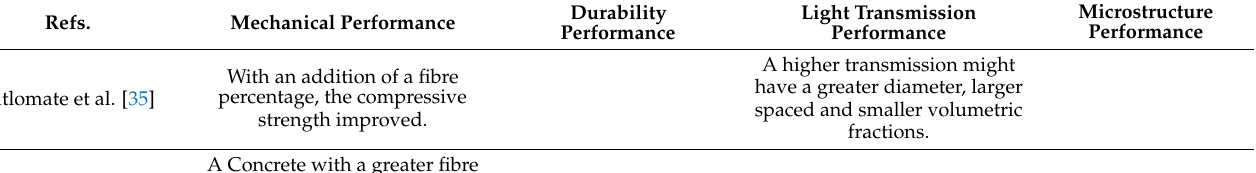
Table 1. Translucent optical fibre components provide an overview of the current LTC database.